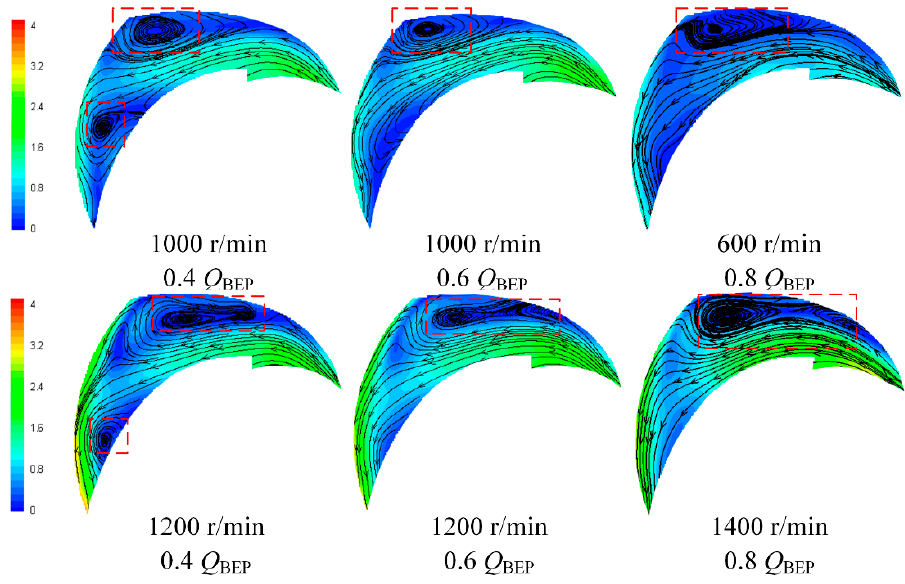
Figure 11. Flow streamlines.